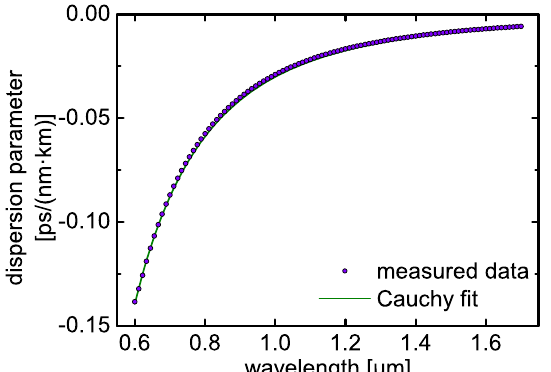
Figure A1. Spectral distribution of the GVD of argon calculated from empirical data (symbols) [37] and from Equation (A1)